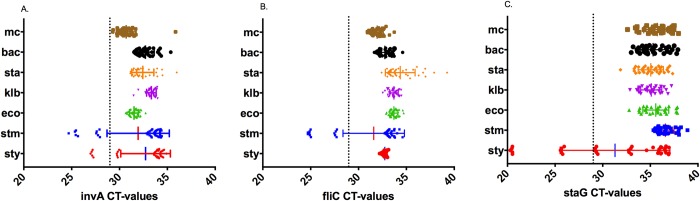
CT cut-off set to demarcate non-specific amplification signals for primers invA (a), fliC (b) and staG (c). Graph shows CT-values from serial dilutions of contaminants; Micrococci (mc), Bacillus (bac), and pathogens; S. Typhi (sty), S. Typhimurium (stm), S. aureus (sta), Klebsiella (klb), and E. coli (eco).